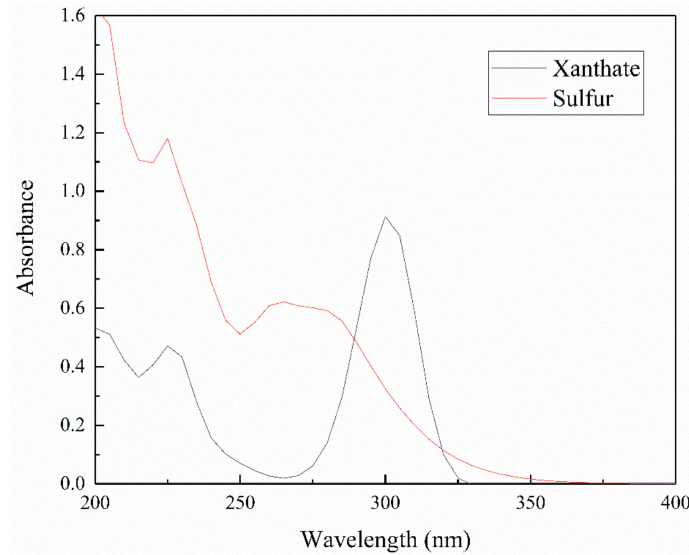
Figure 6. UV absorbance spectra of xanthate and